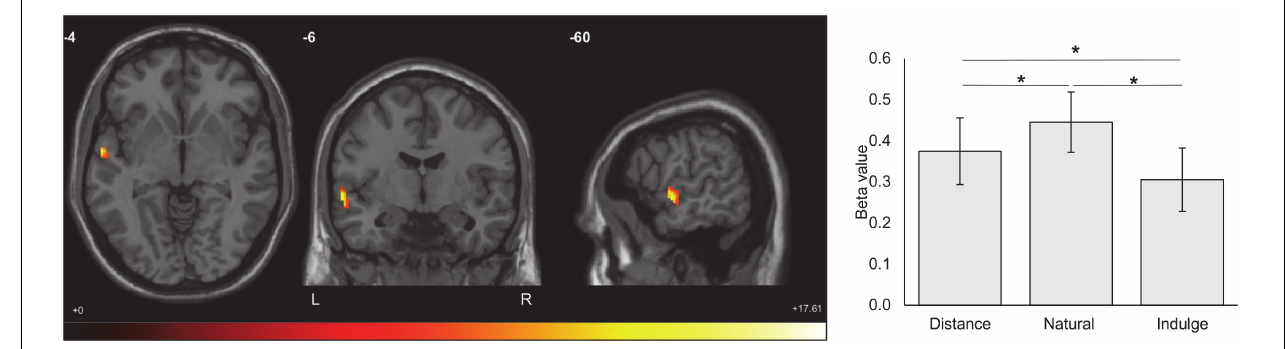
FIGURE 5 | Statistically significant brain regions resulting from the main effect of the cognitive regulation condition (natural, indulge, and distance) for both groups (cluster correction for multiple comparisons, minimum voxel size of 90, p < 0.001, F ( 2 , 54 ) value between 7.87 and 13.97 represented by the colored bar). The distance and indulge trials elicited lower activity than natural trials, and the distance trials lead to higher responses than indulge trials in these regions (distance vs. natural t ( 28 ) = 2.97, p = 0.018, d = 1.12; distance vs. indulge t ( 28 ) = 2.68, p = 0.036, d = 1.01; natural vs. indulge t ( 28 ) = 4.97, p = 9 × 10 - 5 , d = 1.88). These regions include the superior (Brodmann area 22) and middle temporal gyrus (Brodmann area 21), the rolandic operculum, and the precentral gyrus (Brodmann area 6). The numbers above the slices represent the Montreal Neurological Institute peak voxel coordinates. The black star represents statistically significant differences. The main bars represent the mean values and the error bars represent the standard error. L, left; R,